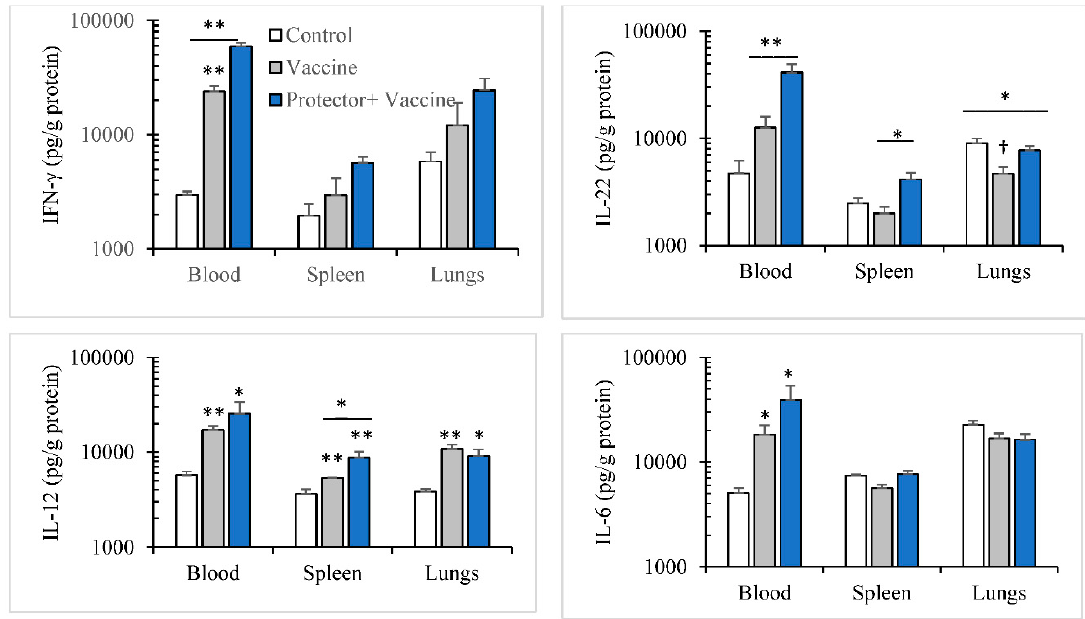
Figure 5. A single/primary immunization with Vaxigrip (5 µg) enhanced the production of IFN- γ , IL-12 and IL-6 in blood as well as IL-12 in spleen and lungs in comparison to PBS injections (Control). When “Protector” (375 µg × 3/day) was orally administered for 1 week, it enhanced Vaxgrip effect on the production of IFN- γ in blood, spleen and lungs; IL-22 in blood and spleen; and IL-12 in spleen. On the other hand, Vazxigrip reduced (†) IL-22 production level in the lungs in comparison to control mice and “Protector” administration restored it. (* p < 0.05, ** p < 0.01 in comparison to the control group and the bar represents the significance between the adjacent treatments.).